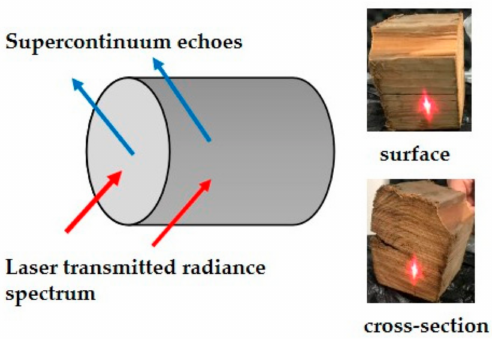
Figure 5. Experiment schematic diagram of surface and cross-section